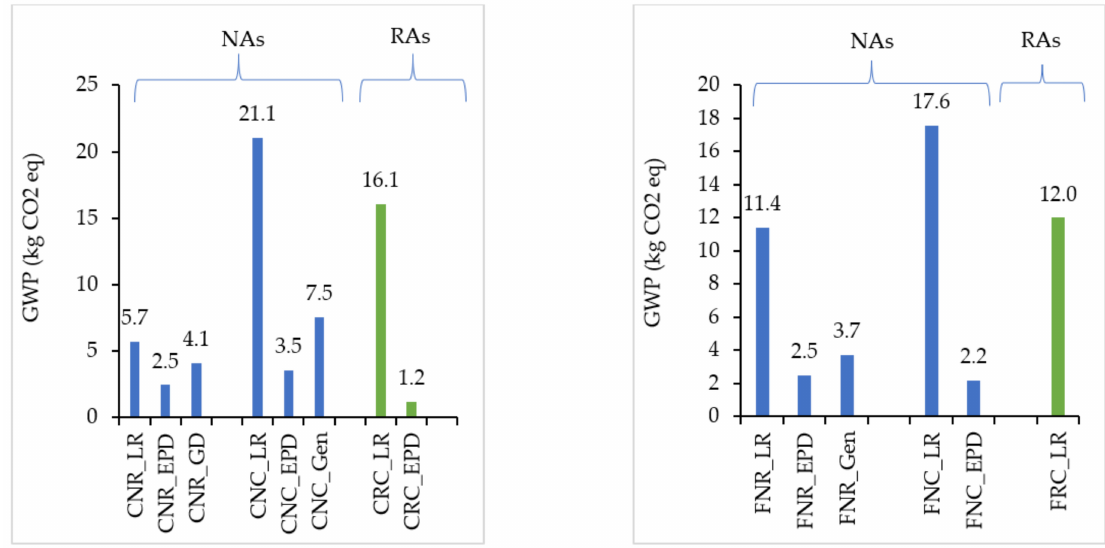
Figure 7. Comparison of the results in terms of GWP (kg CO 2 eq) of NAs and RAs coarse ( left ) and fine ( right ) aggregates from the different